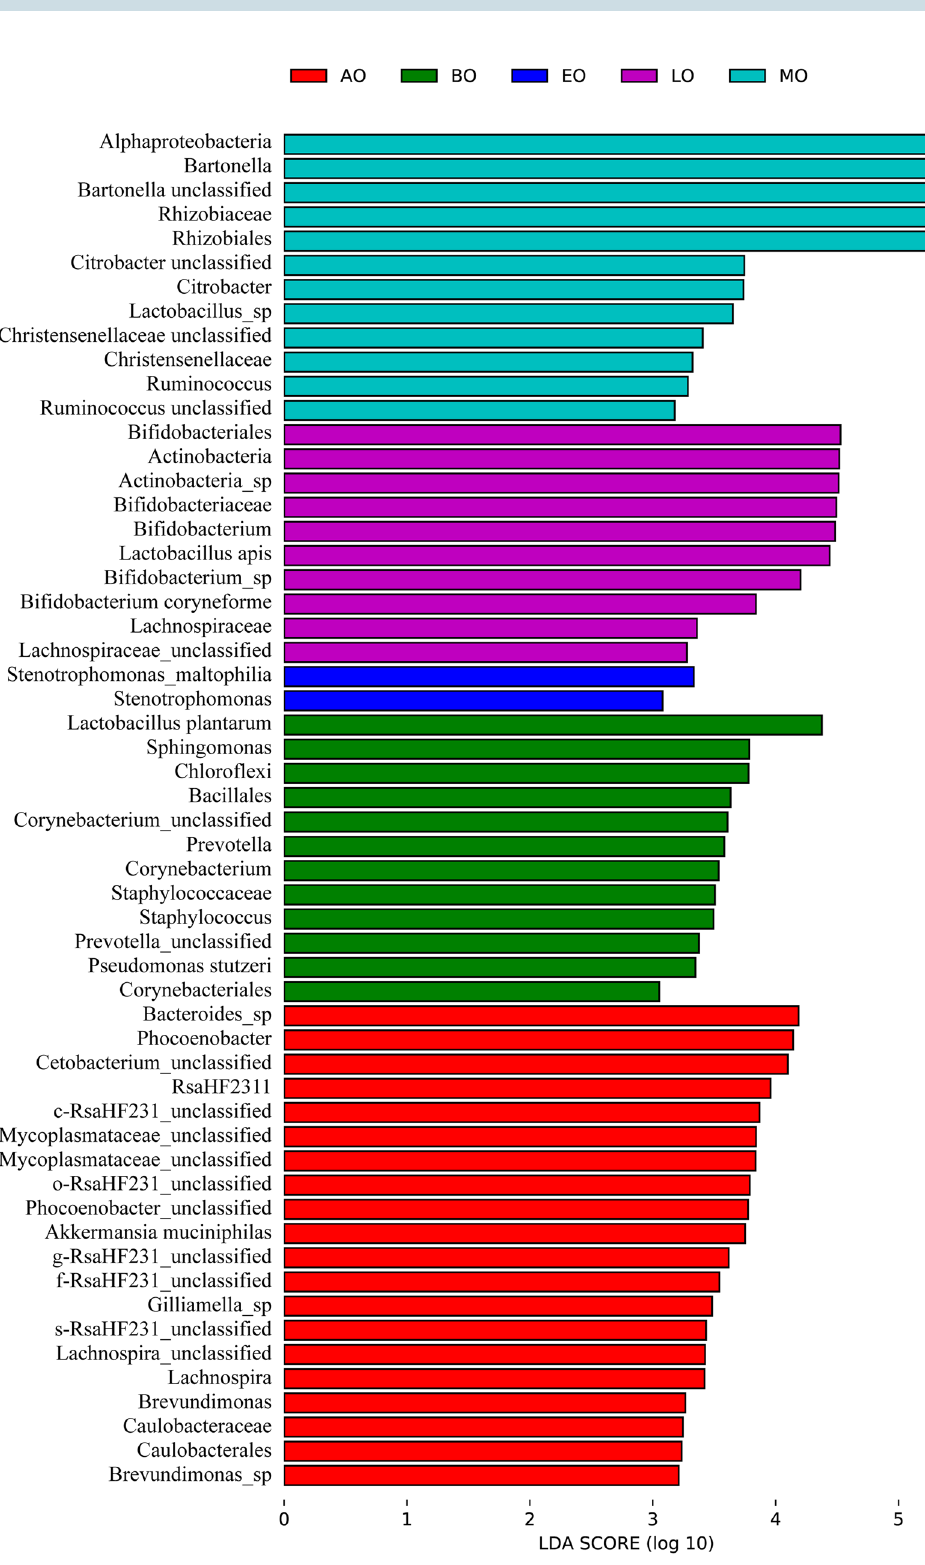
Figure 7. LEFSe analysis illustrating differentially abundant bacteria among samples with different haze